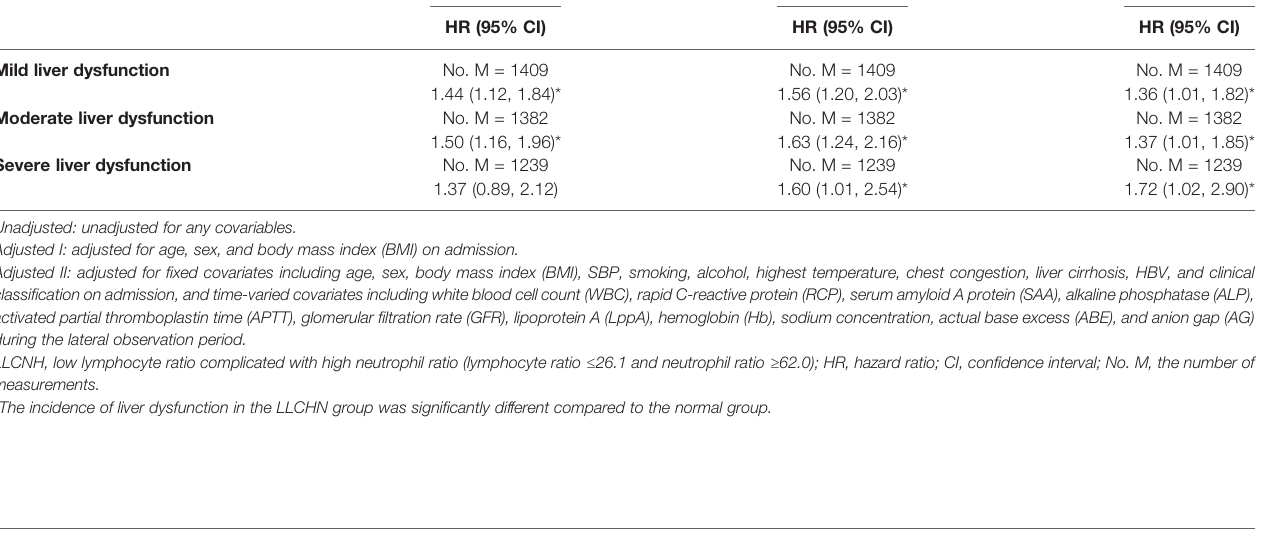
TABLE 2 | Lateral relations of LLCNH to the incidence of liver dysfunction events in the COX model.